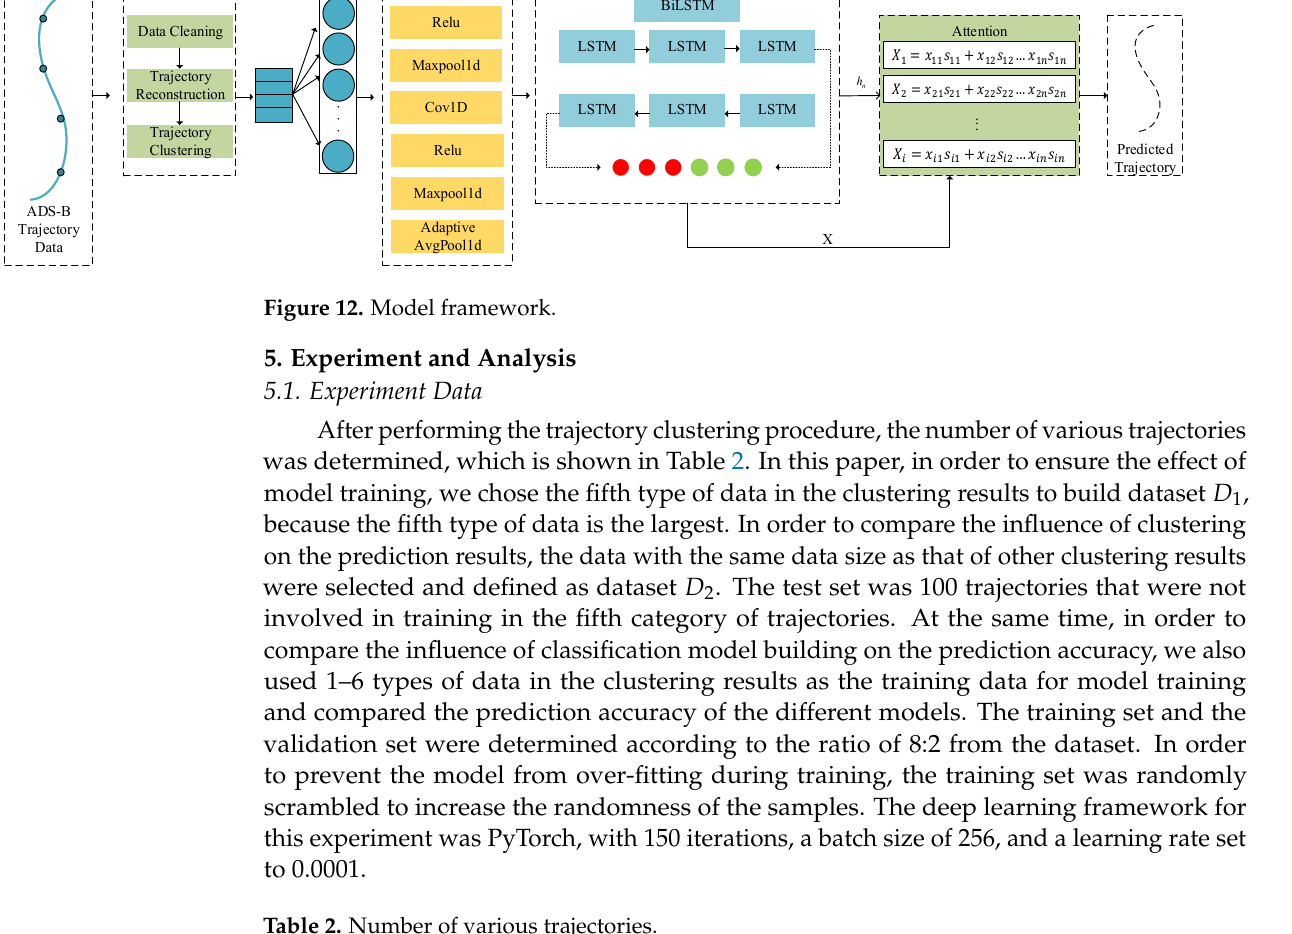
n X X Figure 11. Attention model structure. 4.4. Model Framework In this paper, we used the historical trajectory points of the aircraft as input to the model. The input can be expressed as (none, 10, 4); none represents the batch size of the input, 10 represents the input of 10 historical points of input, and 4 represents the feature dimension of each point, so the input is a data matrix of 10 4  . The output can be ex ‐ pressed as (none, 1, 2), representing the point predicted by the model. The core of the model is a one ‐ dimensional CNN, BiLSTM, and Attention. First, the data are input into the CNN model, and the trajectory data first pass through a 1D convo ‐ lution layer (Cov1d), where the activation function is ReLU, and then pass through a max pooling layer. The above convolution, activation, and pooling operations are repeated, and then the data go through a 1D average pooling layer; after the above process, the spatial features between the trajectories can be better extracted, and then the output of the CNN model is input to the BiLSTM model to extract the features with time correlation between trajectories. Next, the output of the trajectory that reflects the spatiotemporal in ‐ formation obtained in BiLSTM and the final hidden state